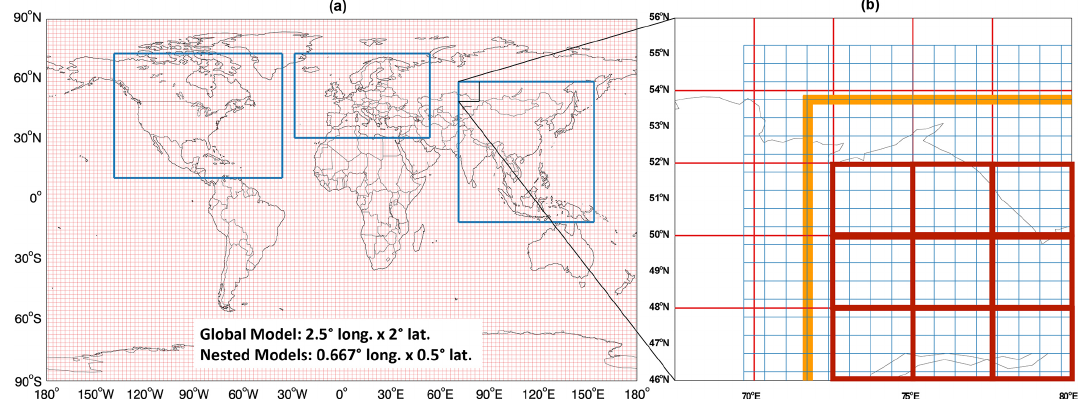
Figure 2. (a) Domains of three nested models covering Asia (70–150 ◦ E, 11–55 ◦ N), North America (140–40 ◦ W, 10–70 ◦ N) and Europe (30–50 ◦ E, 30–70 ◦ N). (b) Illustration of how global and nested models exchange data in the northwestern corner of the Asian nested domain. Blue denotes nested model grids and red denotes global model grids. Thick yellow lines separate the buffer zone (three outer grid cells) and the inner domain of the nested model. To obtain LBCs, the nested model grid cells in the buffer zone adopt mixing ratios of chemicals from the global model. Global model results in the grid cells fully covered by the inner domain of the nested model (bounded by thickened red lines) are replaced with the nested model results after a mass-conversed regridding